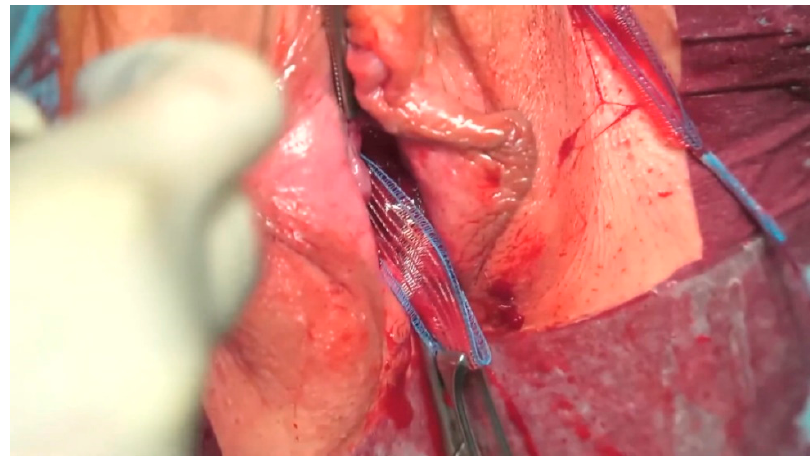
Figure 4. Dallop NM ULTRALIGHT tape implantation—”transobturator” technique.